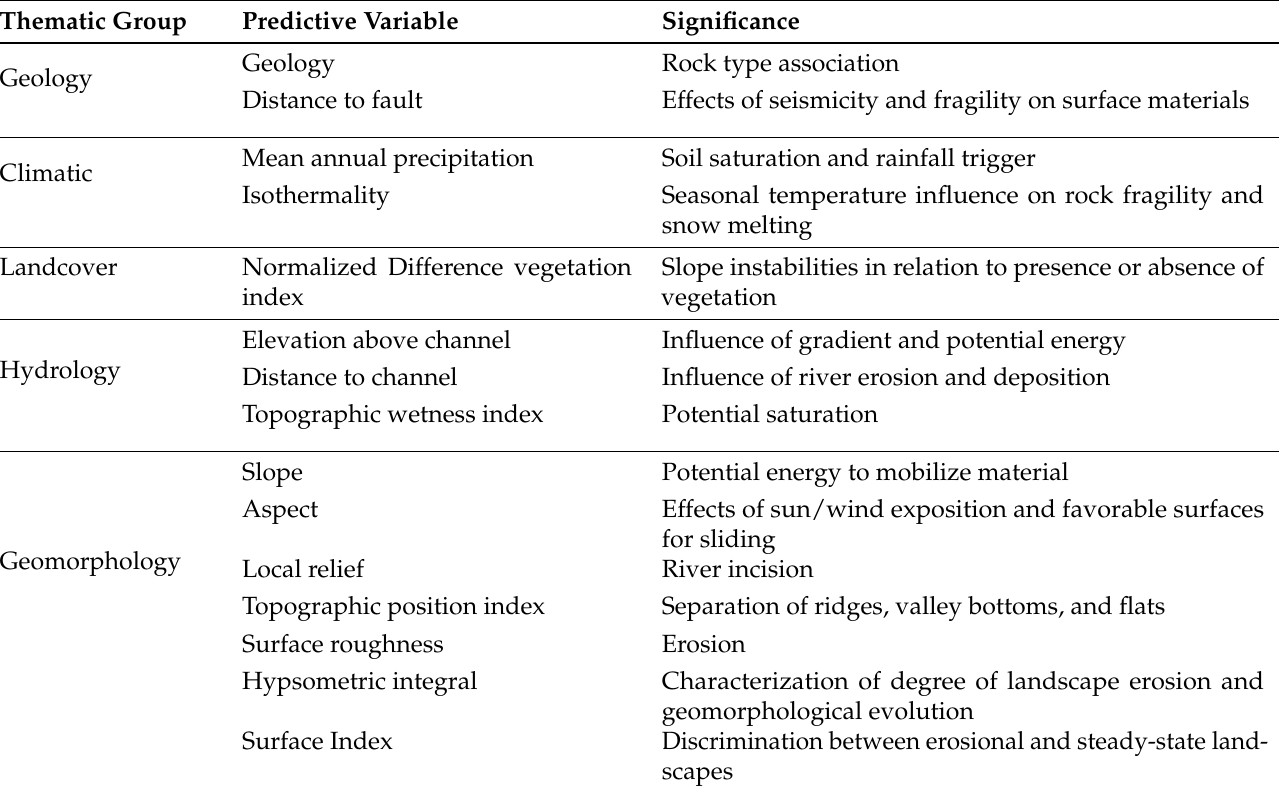
Table 2. Datasets and interpreted